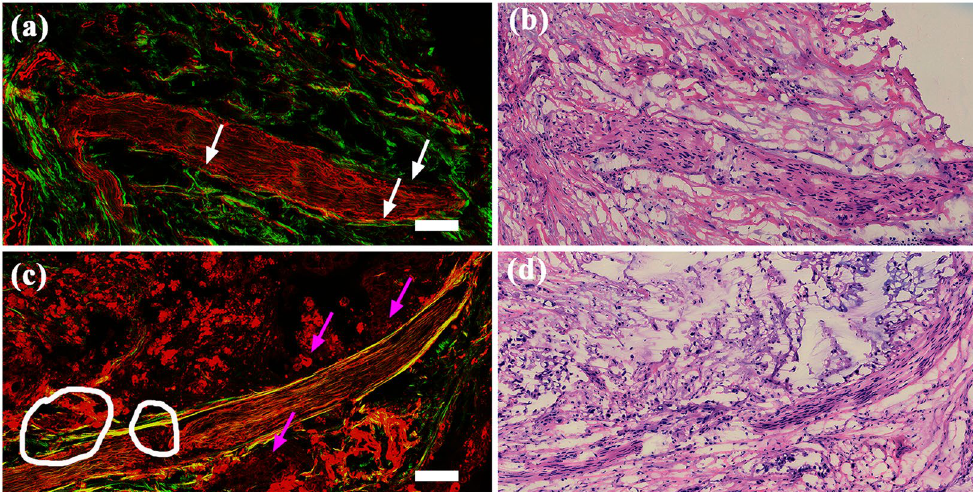
Figure 4. MPM images and corresponding H&E-stained images of a normal nerve and a tumour infiltrating nerve. Magnification of H&E-stained images is 40 × ; Scale: 100 μ m. ( a ) MPM image of normal nerve; ( b ) The corresponding H&E-stained image of normal nerve; ( c ) MPM image of tumour infiltrating nerve; ( d ) The corresponding H&E-stained image of tumour infiltrating nerve. White arrows: the epineurium; pink arrows: tumour cells in close proximity to nerve; white circle: tumour cells break through the epineurium and infiltrate into the nerve.